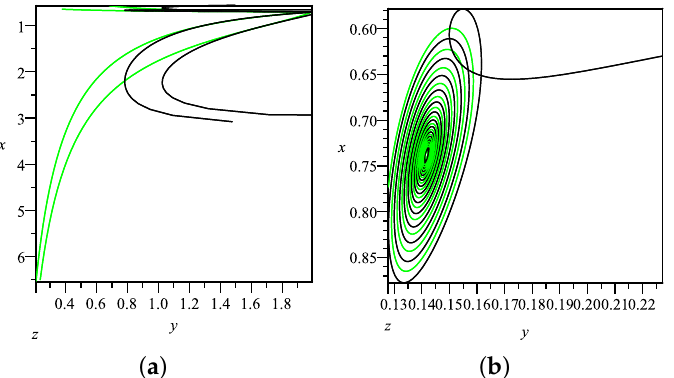
Figure 3. The projection of trajectories from 3-dim phase space onto x - y plane, and z -axis is vertical to the x - y plane. ( a ) The phase plane around P 2 = ( 0.709,1.996,0 ) . The green curves denote EC and the black curves denote LQC; ( b ) The phase plane around P 3 = ( 0.738,0.142,0 ) . The green curve denotes EC and the black curve denotes